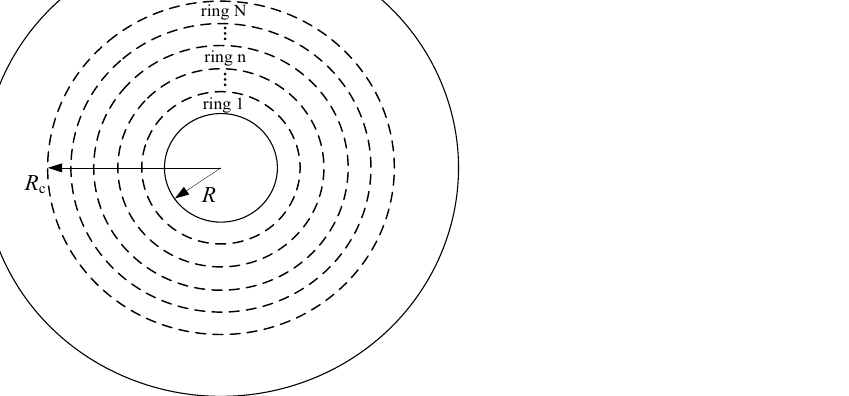
is the critical mass loss of steel bars when the CCS